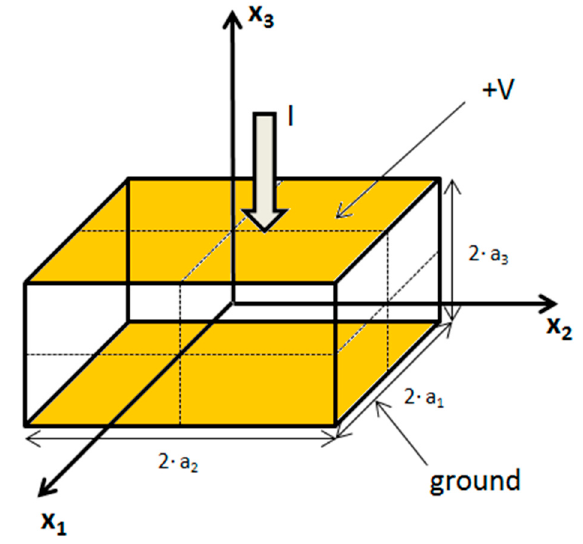
Figure 1. Axis orientation and conventions used in the model.